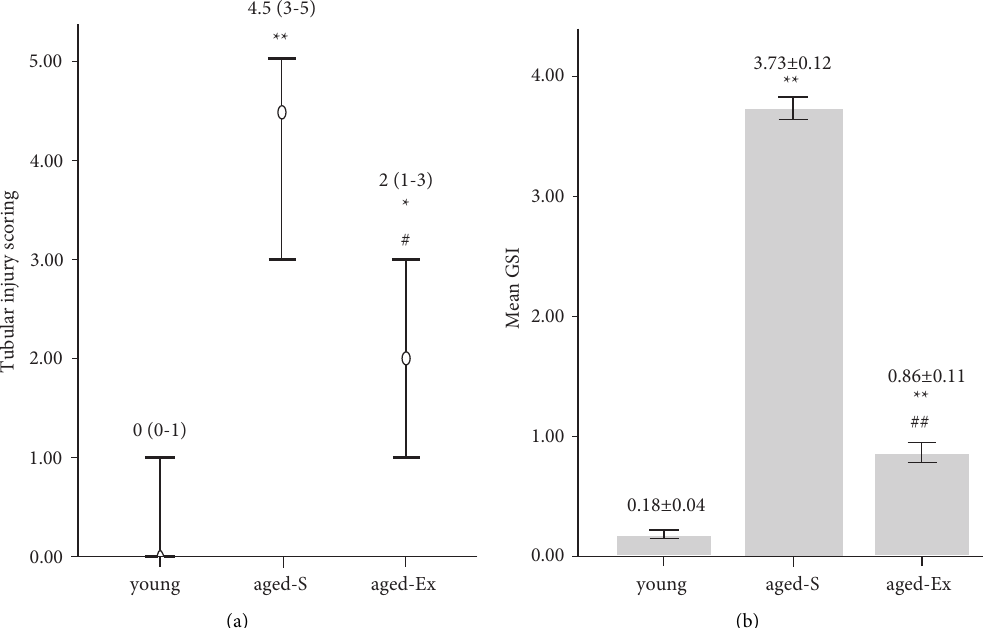
Figure 5: (a) A chart denoting the median and range of tubular injury score in the young, sedentary aged (aged-S), and exercised aged (aged- Ex) groups. ∗ indicates P < 0 . 05 compared with the young group; ∗∗ indicates P < 0 . 001 compared with the young group; # indicates P < 0 . 05 compared with the aged-S group. (b) A histogram demonstrating the mean glomerulosclerosis index in the young, aged-S, and aged-Ex groups. ∗∗ indicates P < 0 . 001 compared with the young group; ## indicates P < 0 . 001 compared with the aged-S group. The data expressed as median (range) (a) and mean ± SD (b) ( n � 10).